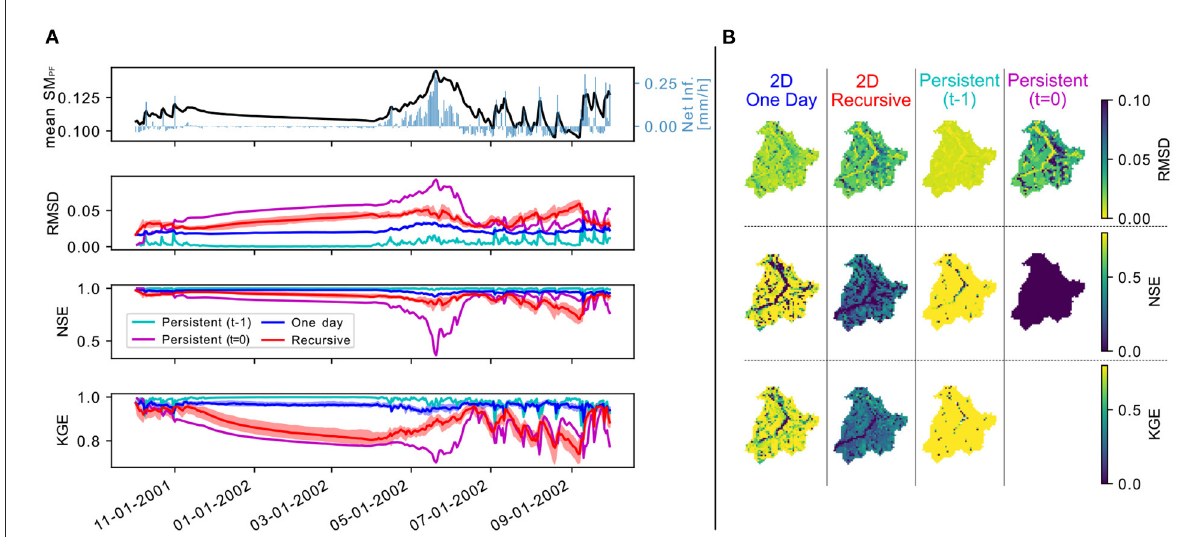
FIGURE3 In (A) , the timeseries of ParFlow-CLM (PF) domain average in time for the water year 2002 (mean SM PF ) and the simulated net infiltration (qflx_infl-qflx_tran_veg ParFlow-CLM variables). Below, the timeseries of Root Mean Square Difference, Nash-Sutcliff Efficiency, and Kling-Gupta Efficiency comparing each day the PF soil moisture field to that of the 2D Convolutional Neural Network (CNN) when predicting 1 day to the next ( 1 Day ) or the entire water year starting from day 0 ( Recursive ). The semi-transparent bands represent the 0.2–0.8 interquartile ranges among repetition of the same ML configuration (i.e., different initialization). In (B) , the temporal statistics comparing the timeseries at each pixel of PF and the 2D CNN in the two configurations, as well as the persistent case in which PF soil moisture is assumed to remain constant either over the entire water year ( Persistent, t = 0 , meaning that the soil moisture is assumed to remain as of 1st October of the chosen water year) or 1 day to the next ( Persistent, t-1